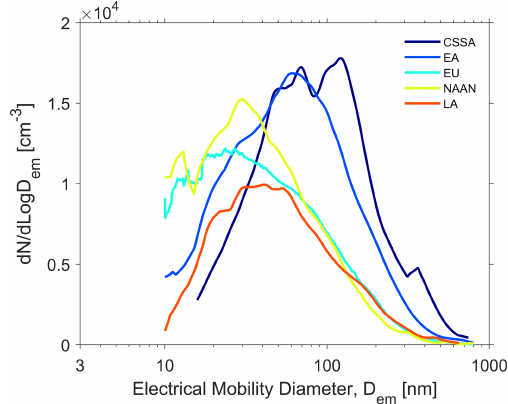
Figure 7. Median number PSDs for each geographical region.